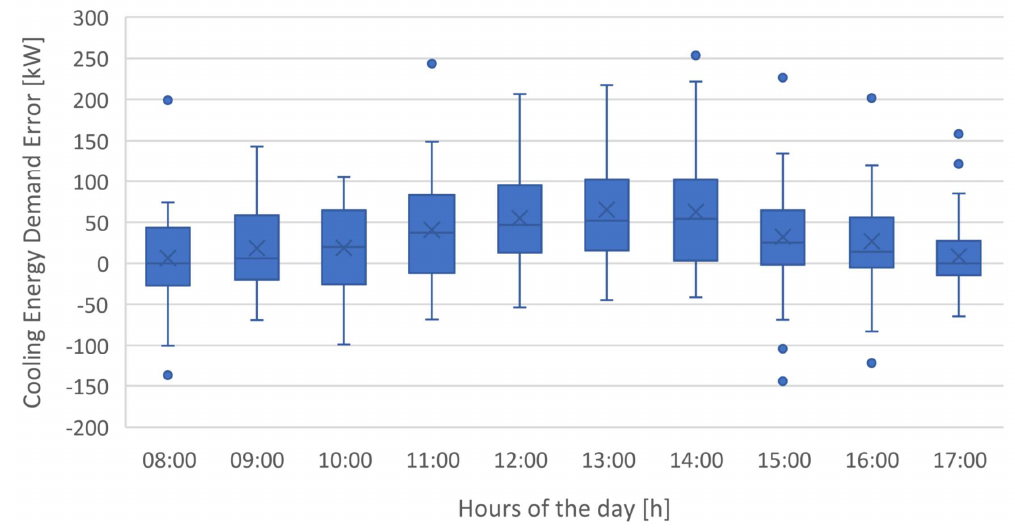
Figure 9. Cooling energy demand error distribution during the test period using ANN.